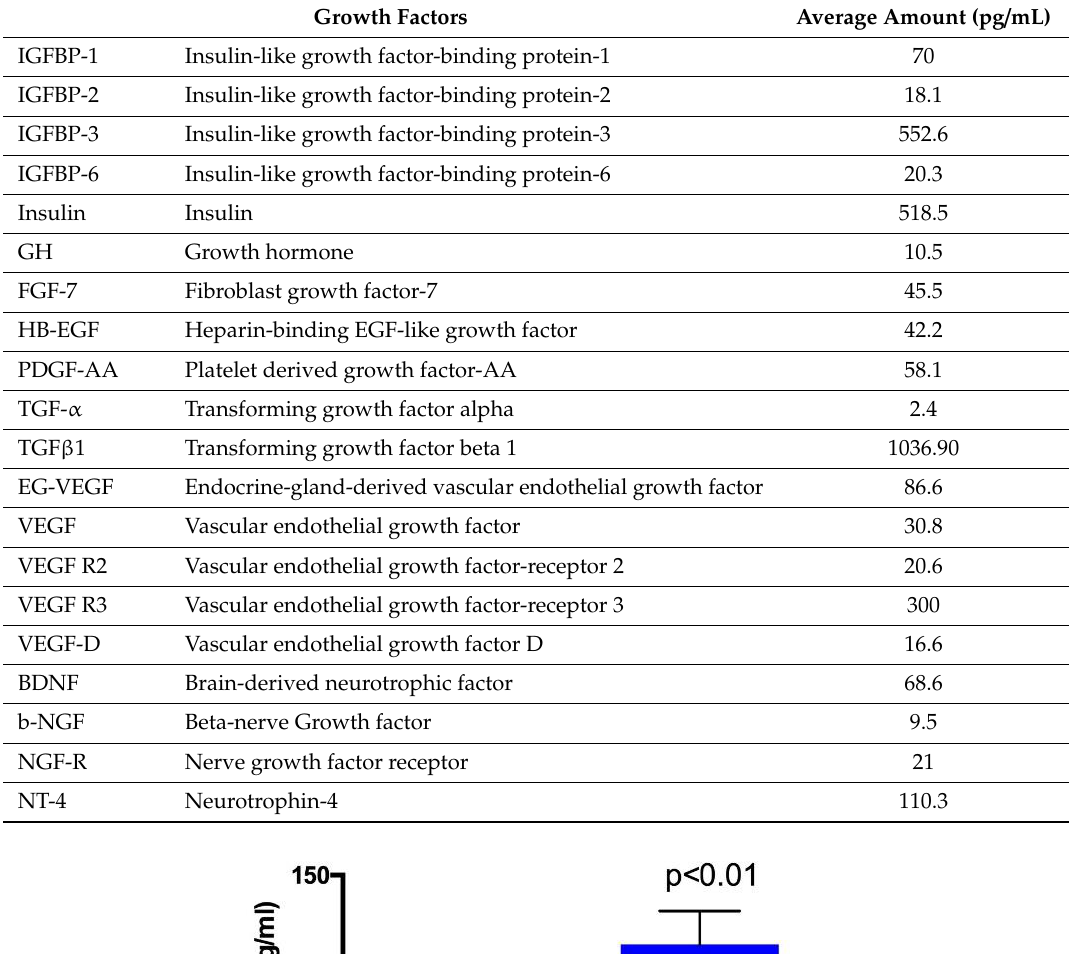
Table 1. Growth factors expressed in the formulated stem cell extract.